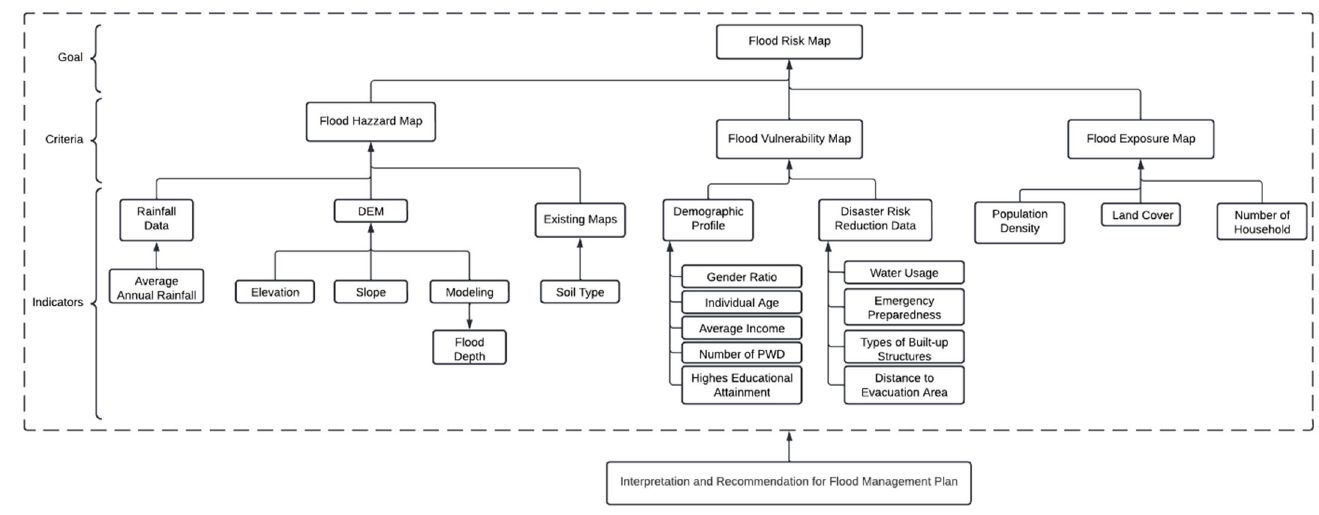
Figure 9. Multicriteria data analysis for flood risk assessment in AHP framework. Table 3. Standard matrix vulnerability parameters.